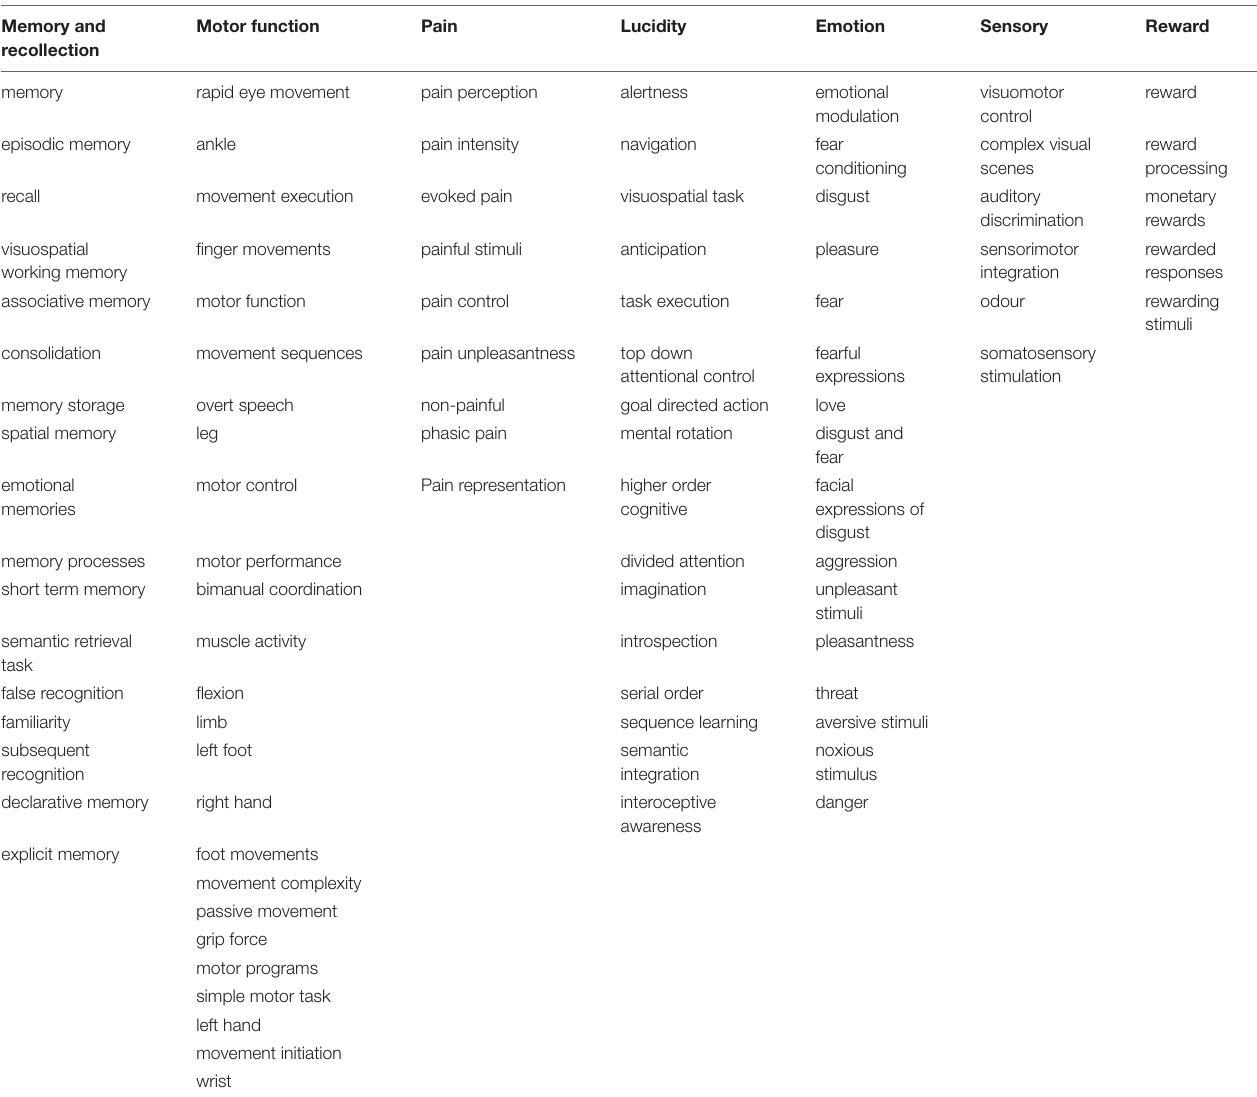
TABLE 1 | Cognitive and sensorimotor functions activating the same regions where ACE2/TMPRSS2 mRNAs are overexpressed, clustered by groups. Memory and